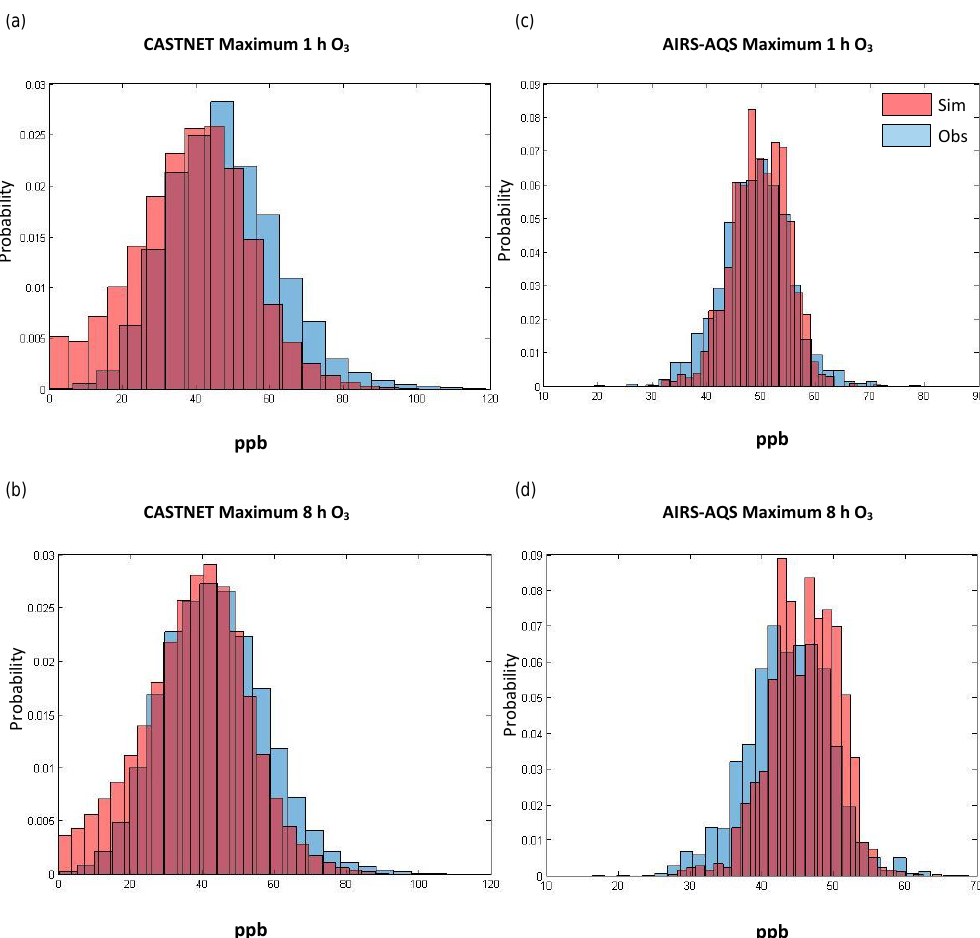
Figure 5. Probability distribution functions (PDFs) of (a) maximum 1h O 3 against CASTNET, (b) maximum 8h O 3 against CASTNET, (c) maximum 1h O 3 against AIRS-AQS, and (d) maximum 8h O 3 against AIRS-AQS for 2001 to 2010 over 30 bins in the respective ranges for all